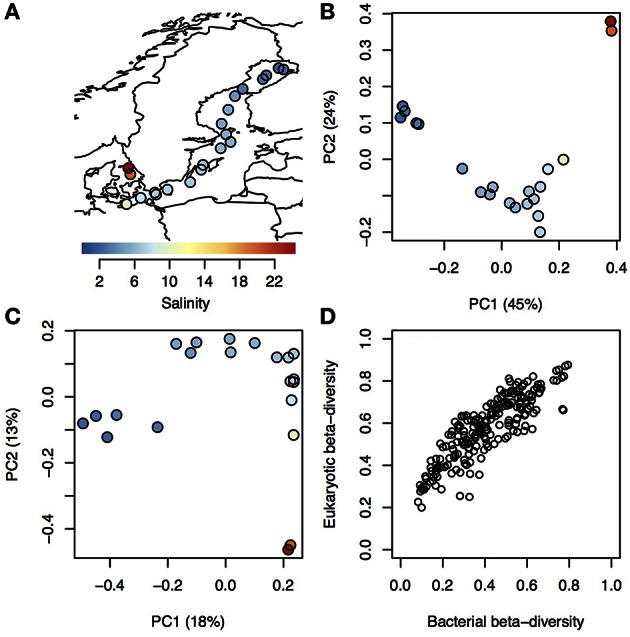
Trends in bacterial and eukaryotic beta-diversity. (A) Map showing sampling sites within Kattegat and the Baltic Sea, with salinity indicated by color. (B–C) Ordination of bacterial (B) and eukaryotic (C) communities using Principal Coordinate Analysis (PCoA) based on beta-diversity calculated using Spearman correlation of OTU frequencies. Samples are colored and sized according to (A). Variation explained by the principal components (PCs) are given within parenthesis. PC1 was highly correlated with salinity for both bacterial and eukaryotic communities (Spearman ρ > 0.97 and P < 10−5 for both). (D) Pairwise dissimilarity score (beta-diversity) between all samples in the dataset, where the eukaryotic scores (y-axis) are plotted against the bacterial scores (x-axis) from the same samples.